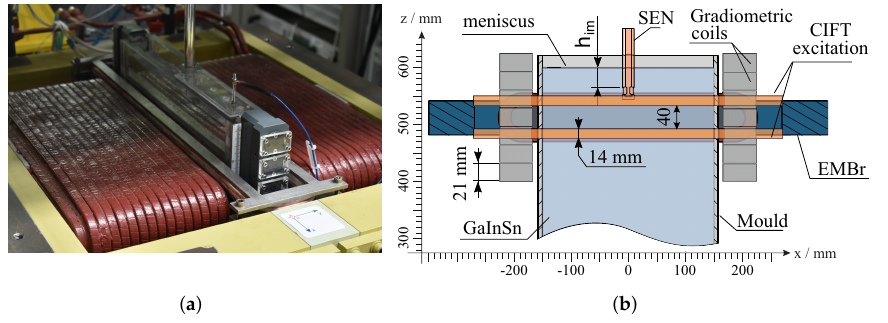
Figure 1. Experimental setup containing contactless inductive flow tomography (CIFT) coils and sensors and the electromagnetic brake (EMBr). Two excitation coils generate a primarily vertical magnetic field. Fourteen gradiometric coils, seven on each narrow side, are used to measure the flow-induced magnetic field. EMBr generates a strong magnetic field below the submerged entry nozzle (SEN), perpendicular to the wide side of the mould. ( a ) Photograph of the mould and CIFT coils. ( b ) Sketch adopted from Schurmann et al.